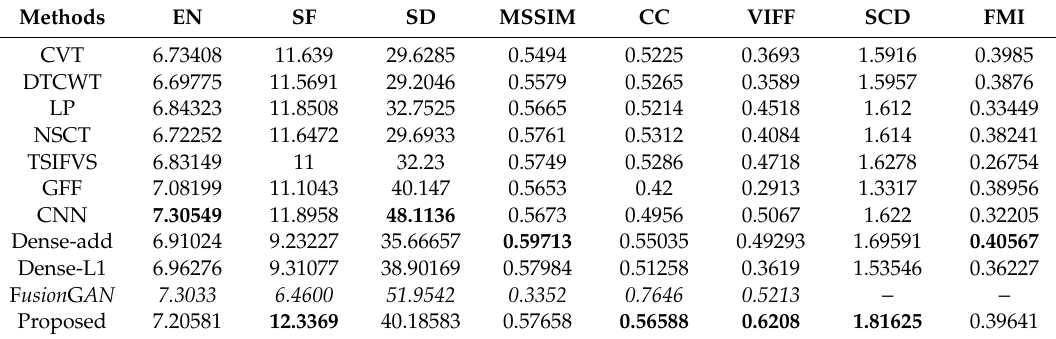
Table 4. The average values of the eight metrics on 10 fused